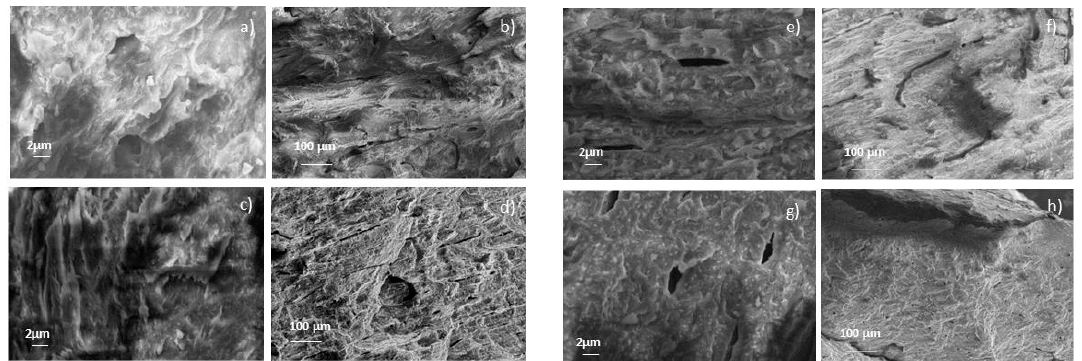
Figure 4. SEM images of bovine bone ( a , b ), porcine bone ( c , d ), equine bone ( e , f ) and ovine bone ( g , h ). Right (magnitude = 200×), left (magnitude = 5000×).